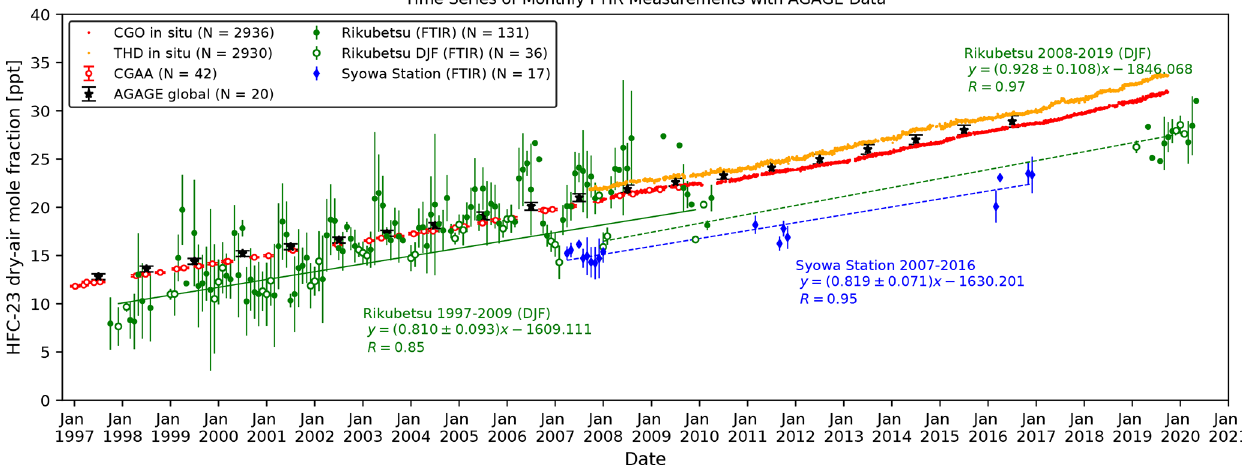
Figure 7. Time series of the monthly mean FTIR-retrieved X HFC-23 at Rikubetsu and Syowa Station, along with the AGAGE in situ mea- surements at CGO and THD, and the annual global mean mole fractions and the Cape Grim Air Archive samples, which were reported by Simmonds et al. (2018b).